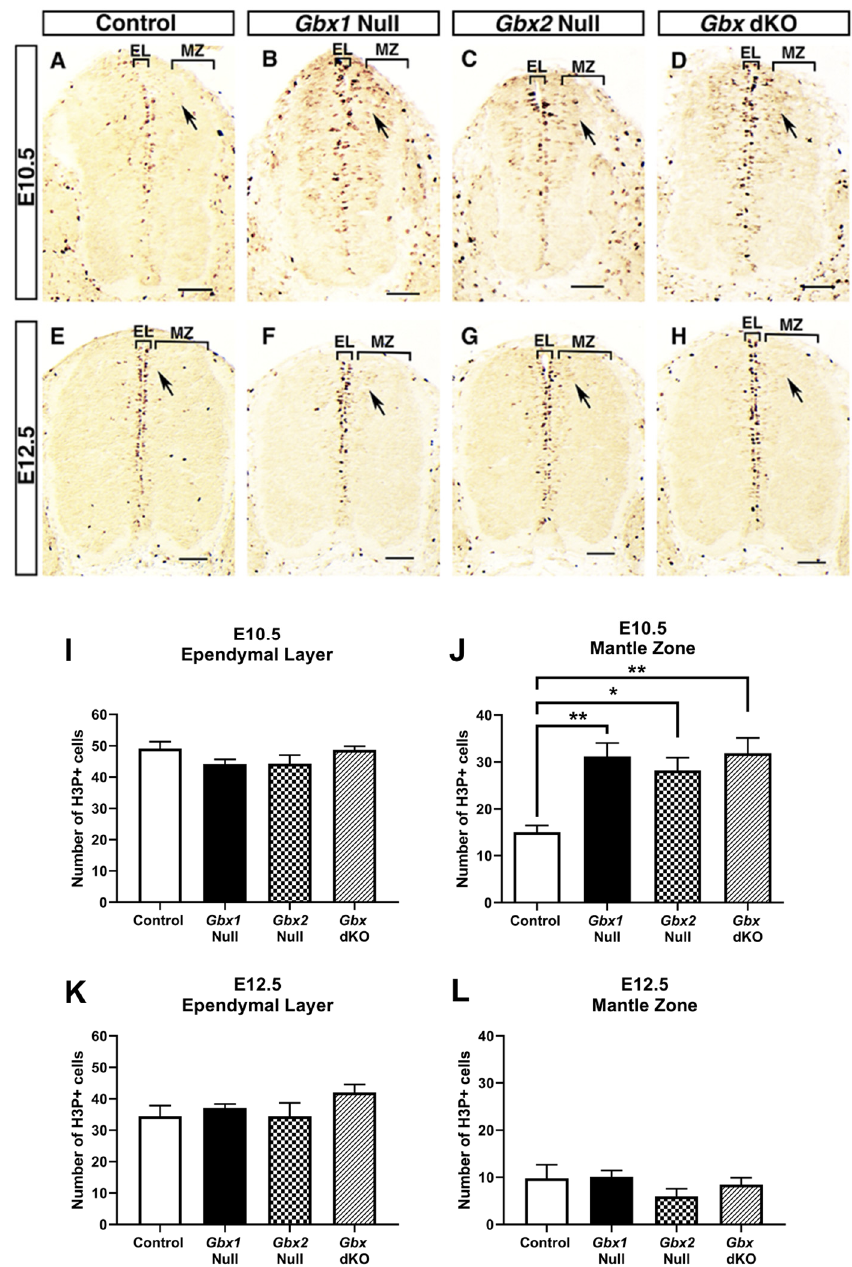
Figure 2. Absence of Gbx gene expression results in aberrant patterning of proliferative cells in the dorsal spinal cord of Gbx mutants. Immunolabeling of apoptotic cells with phosphorylated histone H3 (H3P) at E10.5 ( A – D ) and E12.5 ( E – H ). At E10.5, during the earliest stages of spinal neuron